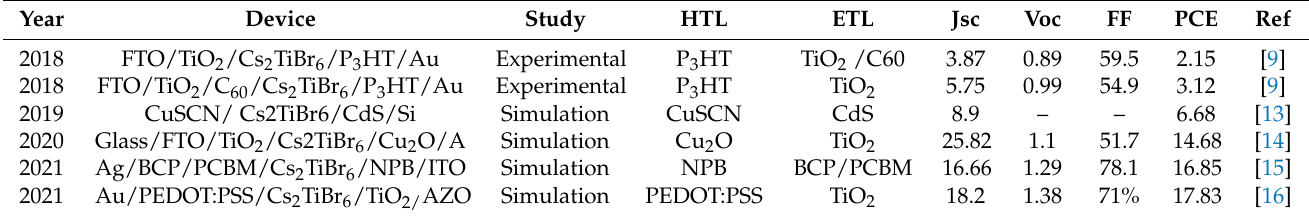
Table 1. Summary of the published photovoltaic responses of Cs 2 TiBr 6 -based perovskite solar